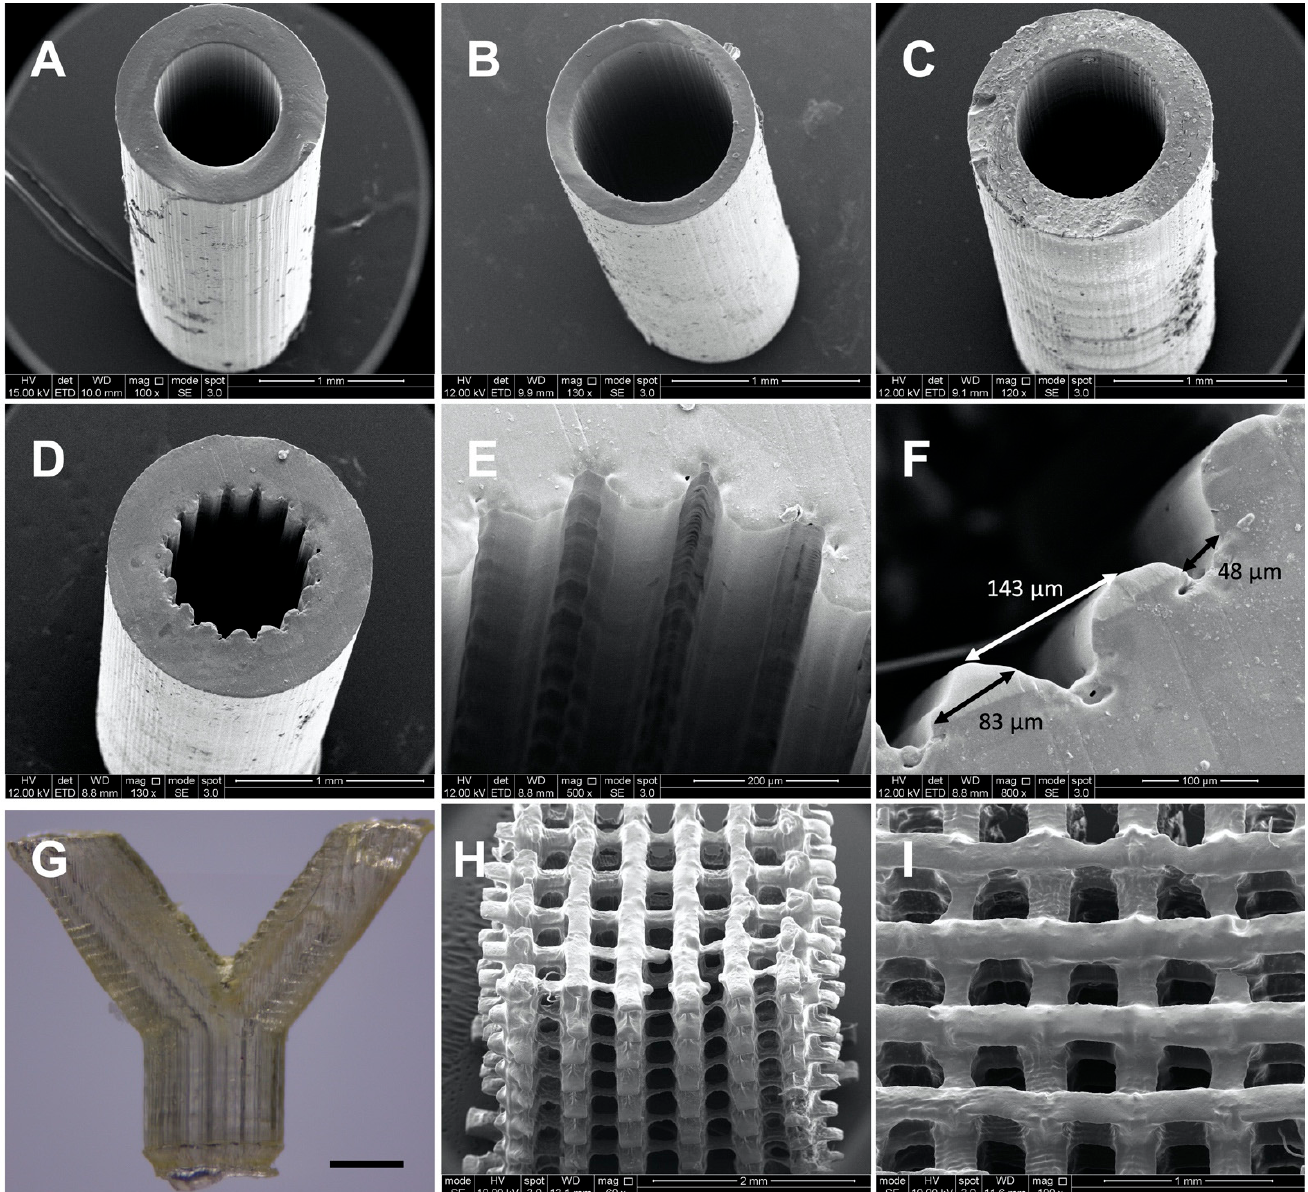
Figure 7. SEM images ( A – F , H , I ) and optical microscopy image ( G ) of constructs produced by microstereolithography using 2M20 PCLMA resin. ( A – C ) simple tubes produced using PCLMA resin containing no photoabsorber ( A , B ) and containing 0.075% β -carotene ( C ). ( D – I ) more complex 3D structures produced using PCLMA resin containing β -carotene as a photoabsorber. ( D / E ) grooved tube, ( F ) annotated image of a grooved tube showing the average groove width (48 µ m), strut width (83 µ m) and peak-to-peak width (143 µ m); ( G ) bifurcated tube, scale bar: 1 mm; ( H / I ) woodpile structure (side view and top view, respectively).